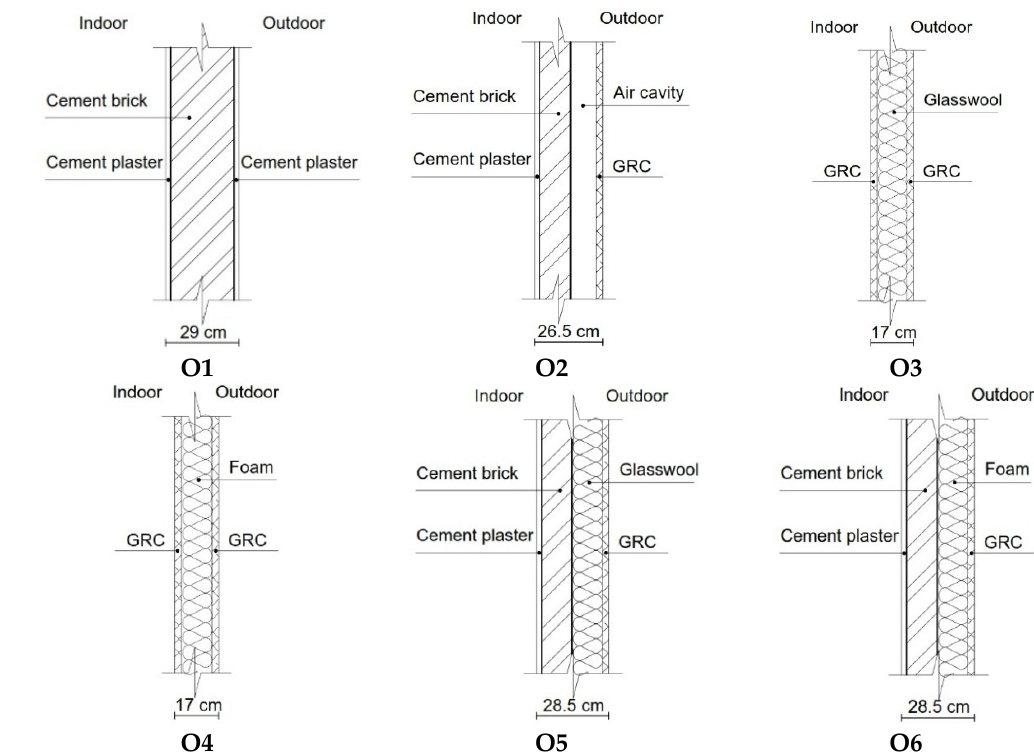
Figure 5. Characteristics of the wall section options. Table 2. The most important thermal properties of the proposed external wall options.